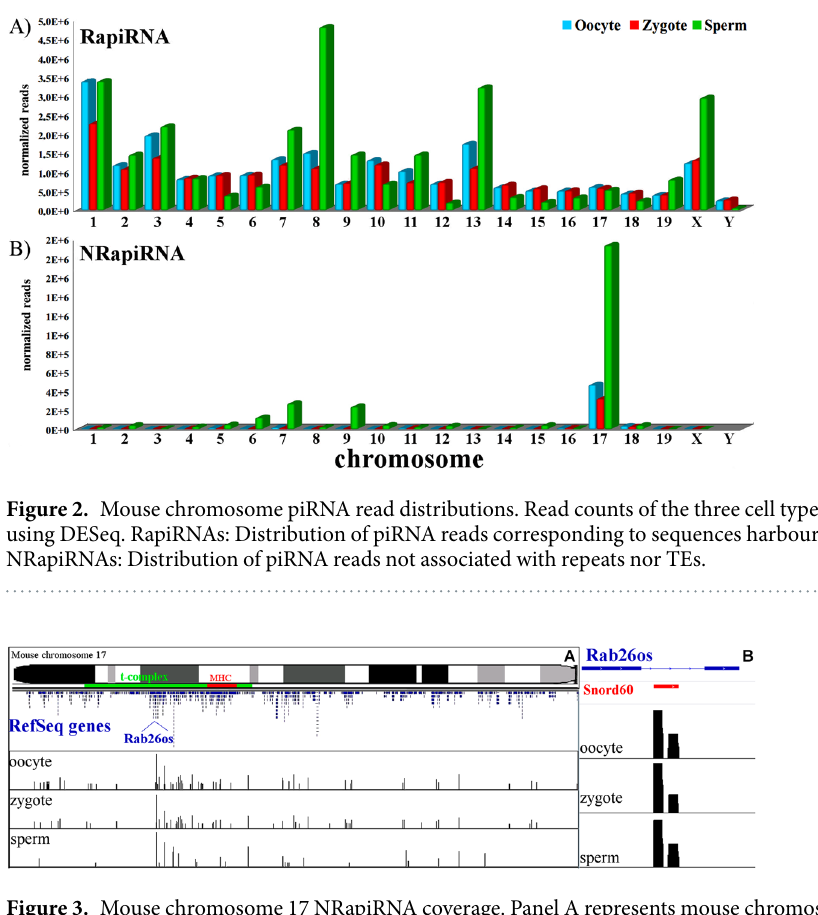
Figure 3. Mouse chromosome 17 NRapiRNA coverage. Panel A represents mouse chromosome 17 with the three cell type coverage tracks. Blue marks represent RefSeq annotated genes on chromosome 17. In green, the mouse t -complex region and in red the MHC gene region. Coverage tracks represented in black for each cell type. Panel B represents coverage tracks of the antisense lncRNA Rab26os including its intron-derived snoRNAs. Bars represent the log transformed coverage values obtained using the IGV software. Structural annotations of Rab26os were obtained from the Ensembl